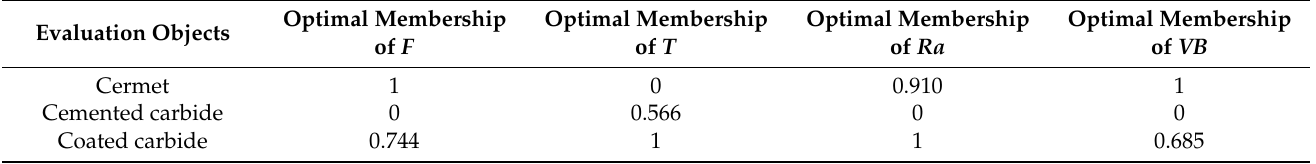
Table 8. Fuzzy membership of evaluation indexes at the cutting speed of 80